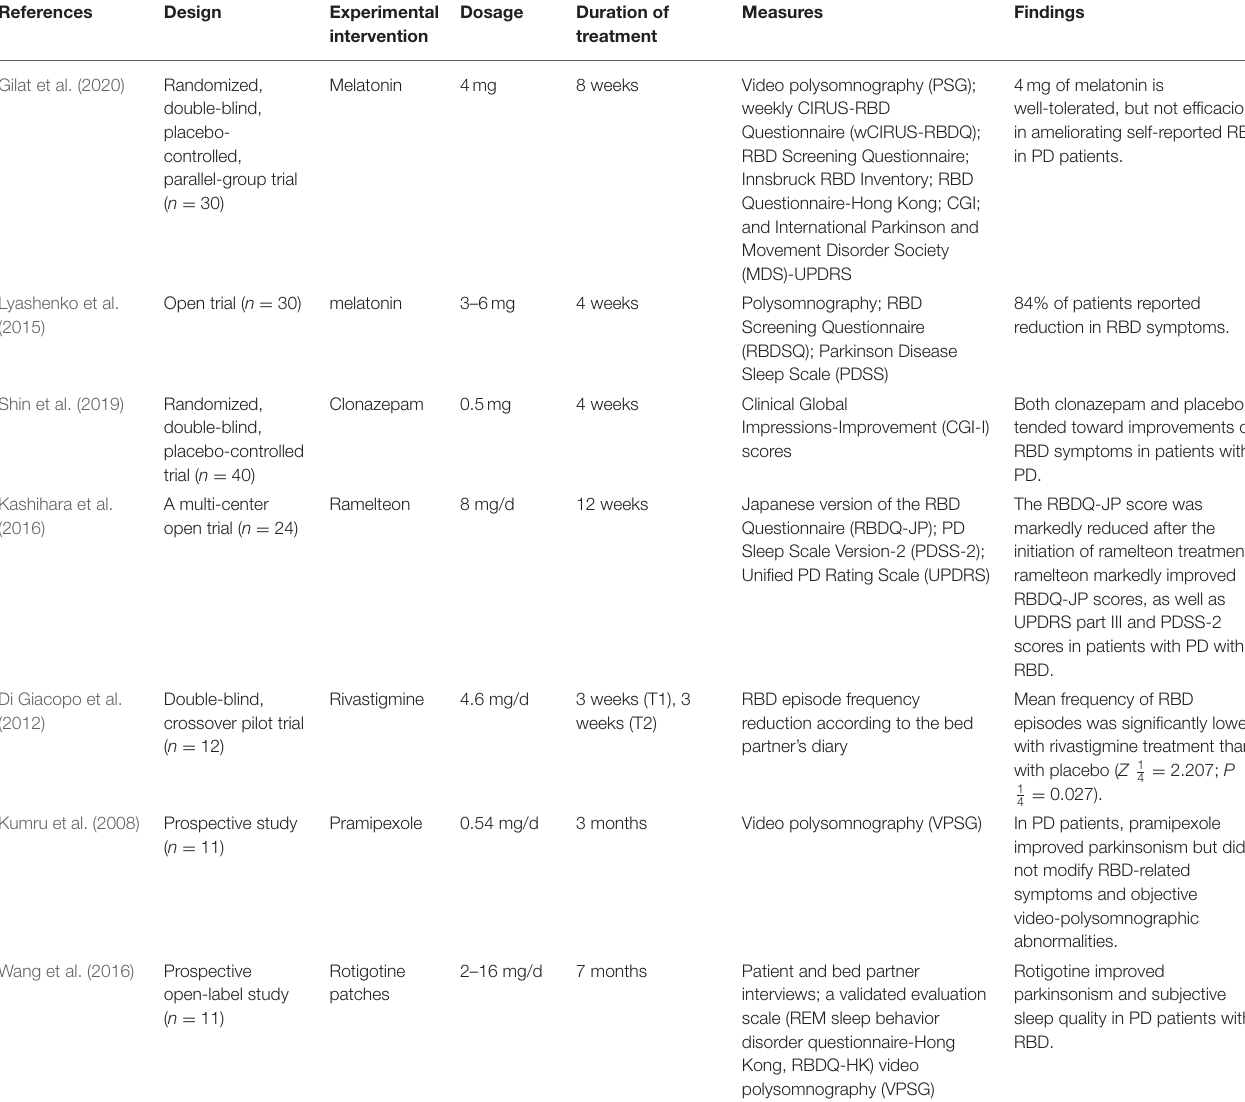
TABLE 1 | Main characteristics of the eligible